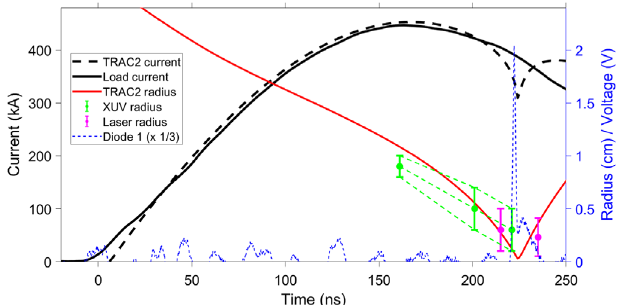
FIG. 9. Comparison of gas puff implosion with results from a 1D simulation using the TRAC - II MHD code: driver current, implosion radius, and x-ray emission. The dashed green lines represent the trajectory of the plasma leading edge (bubbles), average radius, and trailing edge